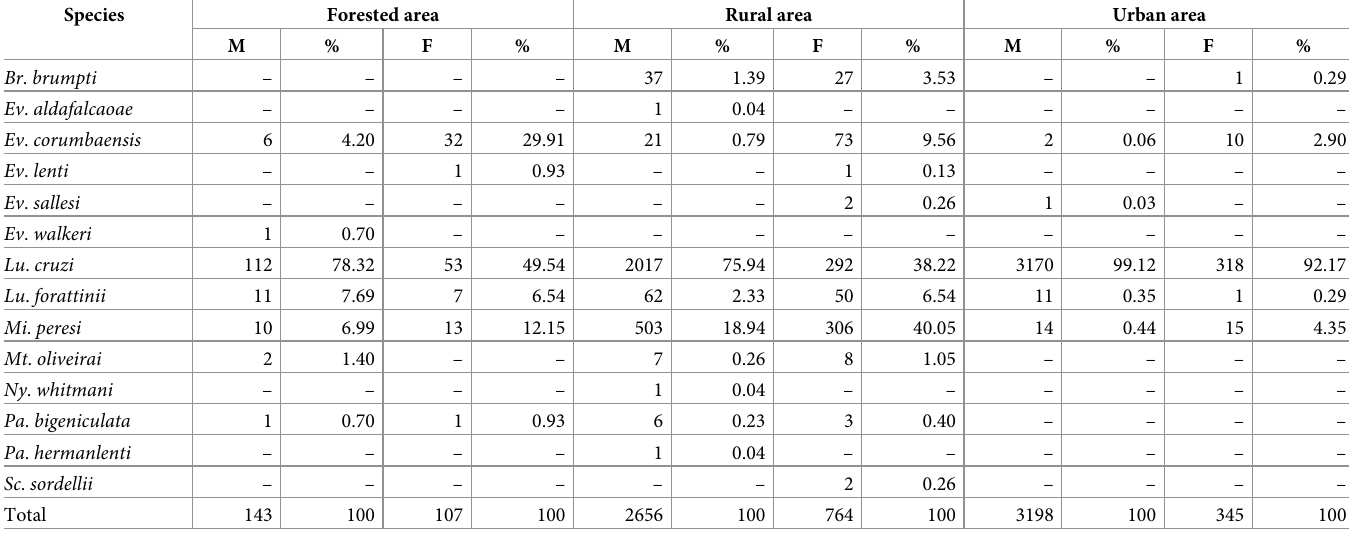
Table 5. Distribution of male and female specimens ( n = 7213), by area (forested, rural, urban). Corumba´, Mato Grosso do Sul, Brazil. May 2015 to April 2017. Species Forested area Rural area Urban area